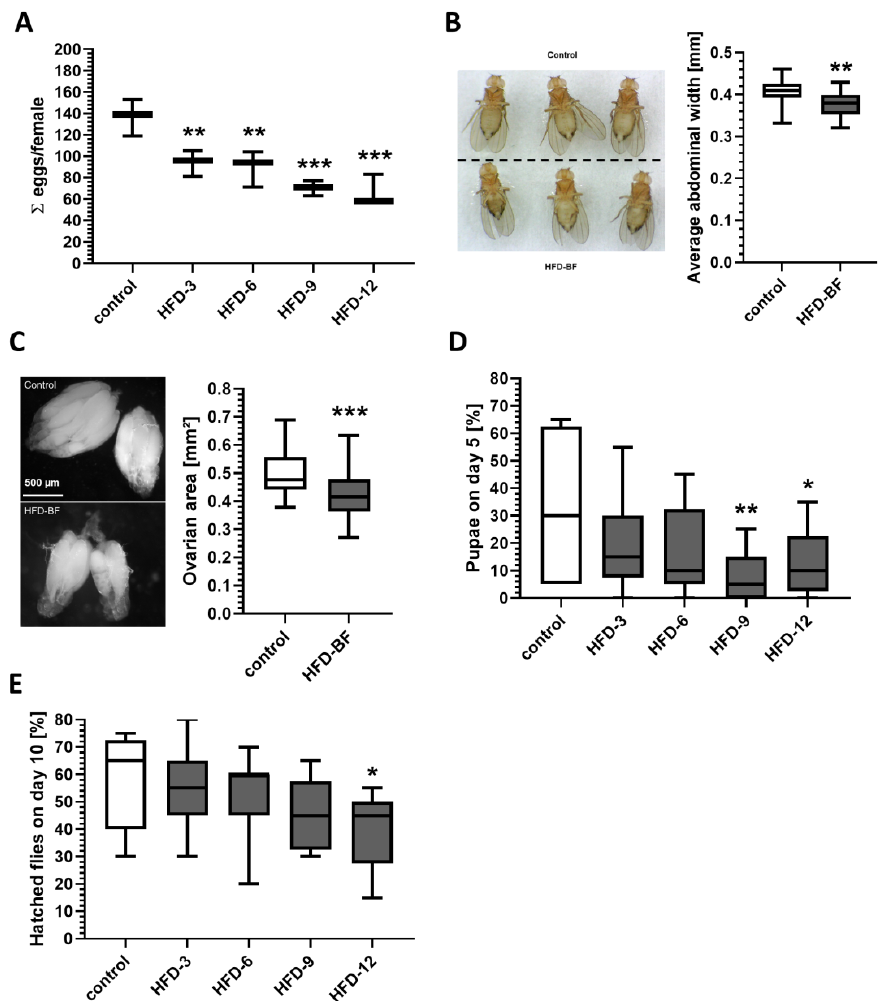
Figure 2. Butter fat (BF) supplementation reduced female fecundity and prolonged the egg to adult development time. ( A ) To examine the impact of increasing concentrations of BF on female fecundity, female D. melanogaster w 1118 were placed on standard control medium or HFD containing 3%, 6%, 9% and 12% ( w / v ) BF. Flies were maintained under standard conditions throughout experimental treatment and the number of laid eggs per vial was counted over a period of 15 days ( n = 3 independent experiments with N = 18 females per treatment in total). The cumulative number of laid eggs per female was significantly and dose-dependently reduced following ingestion of an HFD. ( B ) Compared to controls, the reduced egg laying rate of HFD-BF females was associated with a decreased abdominal width and ( C ) ovary size when analyzed at day 15. The abdominal width ( n = 2 independent experiments with N = 15 females per treatment) and area of ovaries ( n = 2, N = 40 ovaries per treatment) were quantified using ImageJ. ( D ) To investigate the influence of increasing concentrations of BF on fruit fly development, 20 eggs derived from w 1118 females, which were pre-fed with standard food medium were placed on control medium or HFD. The number of pupae and hatched flies per vial were counted for 12 days. A significant time shift in pupae development towards a reduced number of developed pupae out of 20 eggs per vial on an HFD-9 and HFD-12 was observed on day 5. ( E ) A delay of the development time was also visible detected with regard to a reduced number of hatched flies on an HFD-12 on day 10. (For ( D , E ): n = 3 replicates, N = 180 eggs per treatment in total. Data in ( A – E ) are shown as boxplots with whiskers indicating minimal and maximal values. Statistical significance was assumed at * p < 0.05, ** p < 0.01, *** p < 0.001: Significant differences between groups, evaluated by